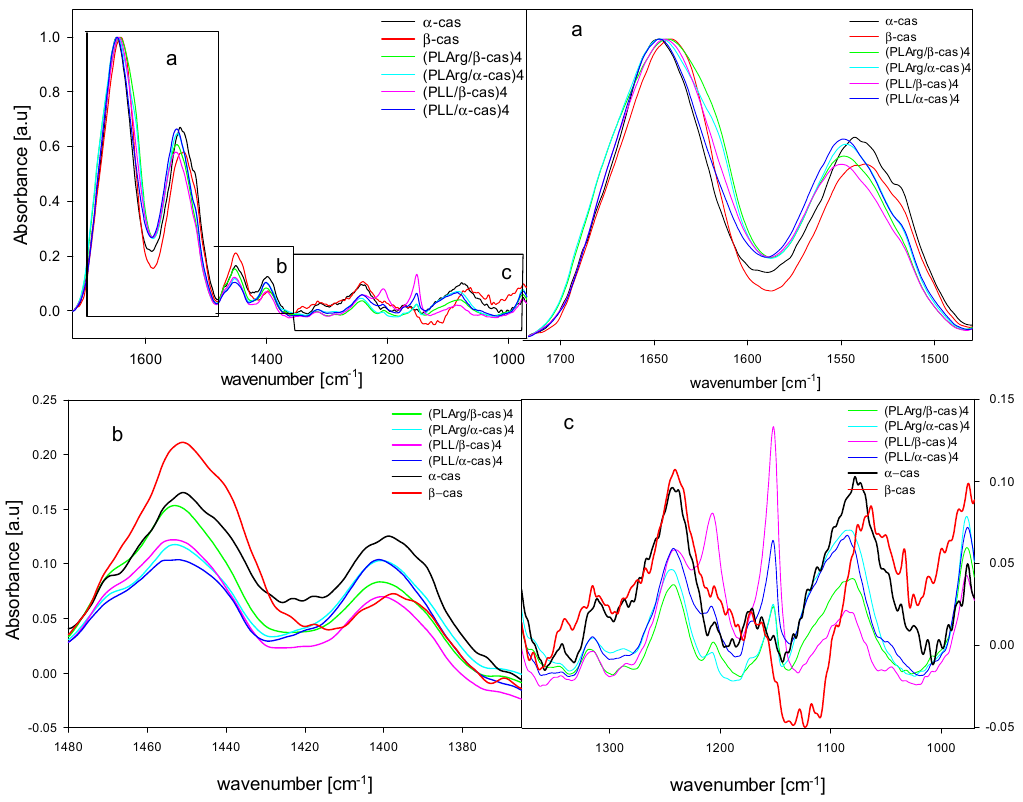
Figure 10. FTIR spectra of free caseins and four bilayer films with PLArg and PLL. Parts a, b, c shows close-ups of part of the spectra illustrated in the top-left figure. Table 5. Decomposition of the amide I vibration band into structural components for casein films and the top casein layers of (PE/casein) and (PE/casein) 4.